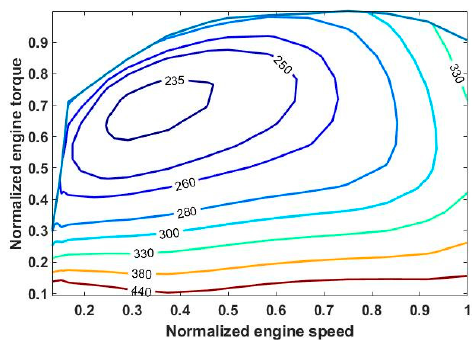
Figure 2. Normalized fuel consumption rate of engine.